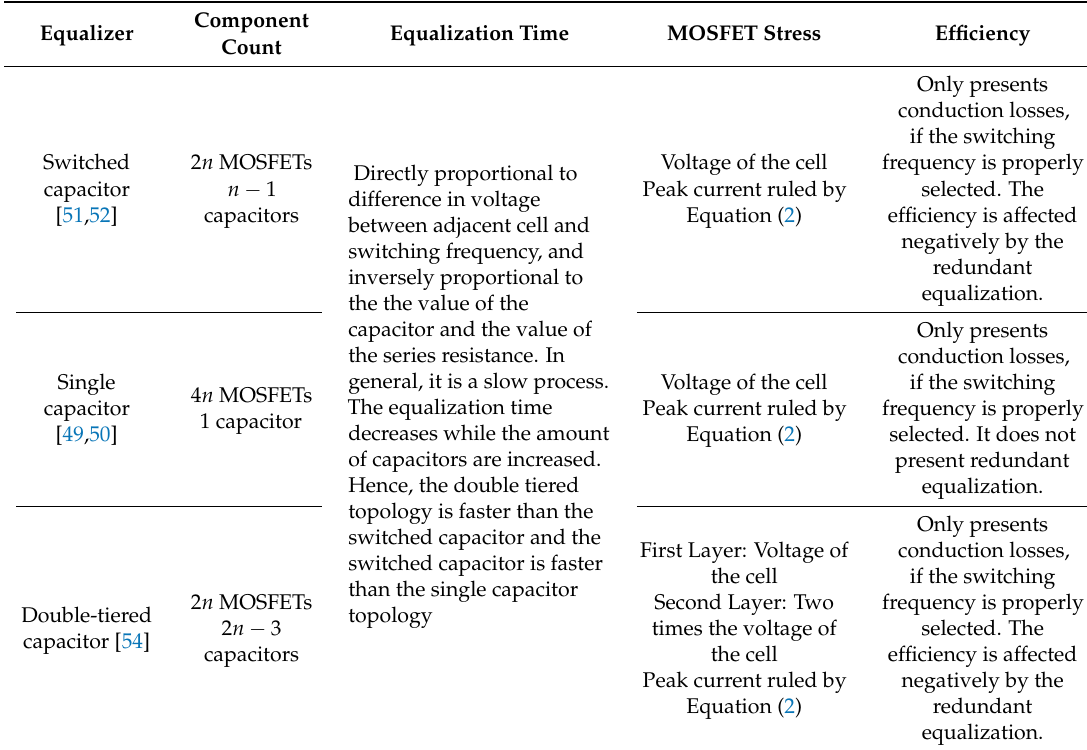
Figure 16. Equalization of a four-cell battery bank using the double-tiered switched capacitor scheme. Table 3. Comparative analysis of capacitor-based